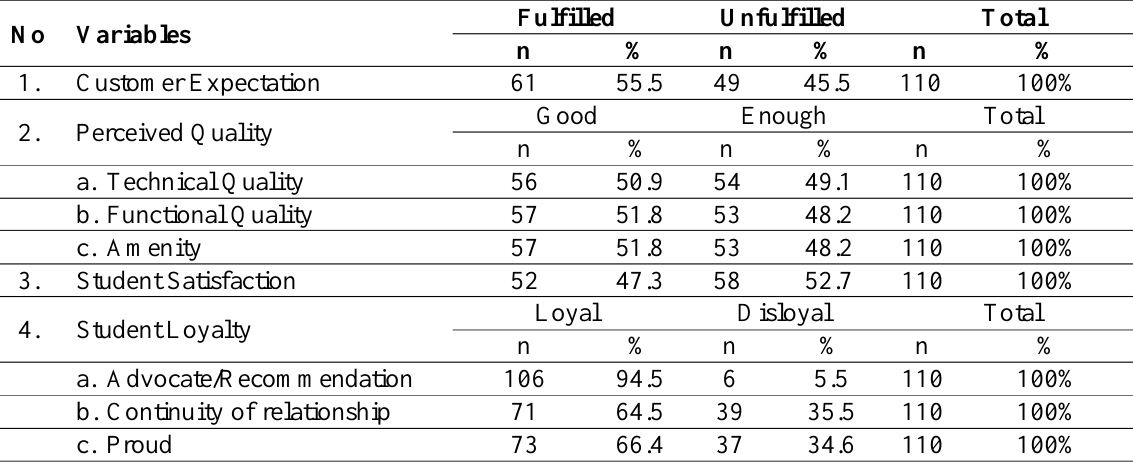
Table 1. Research variables (n = 110) No Variables